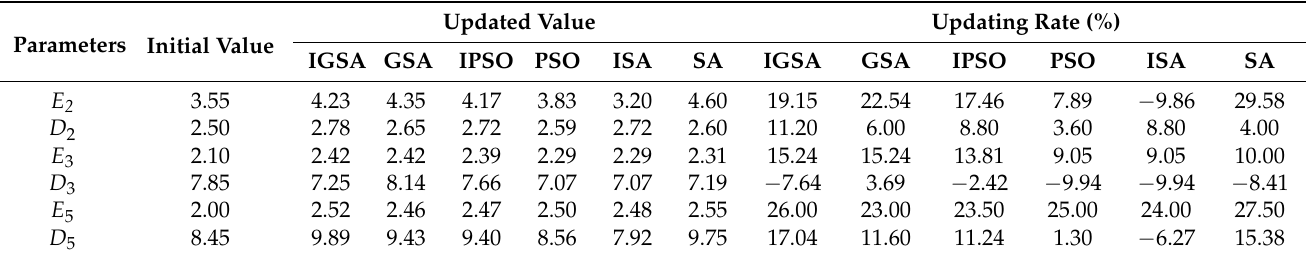
Table 7. Comparison of the design parameters between initial values and updated values.